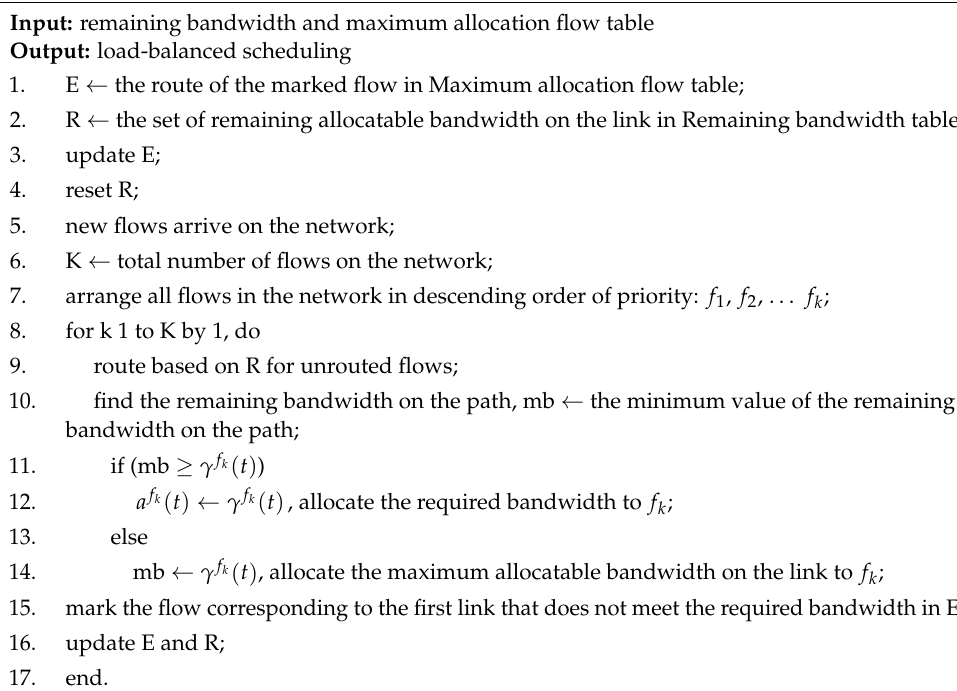
Algorithm 1. Dynamic Routing Network